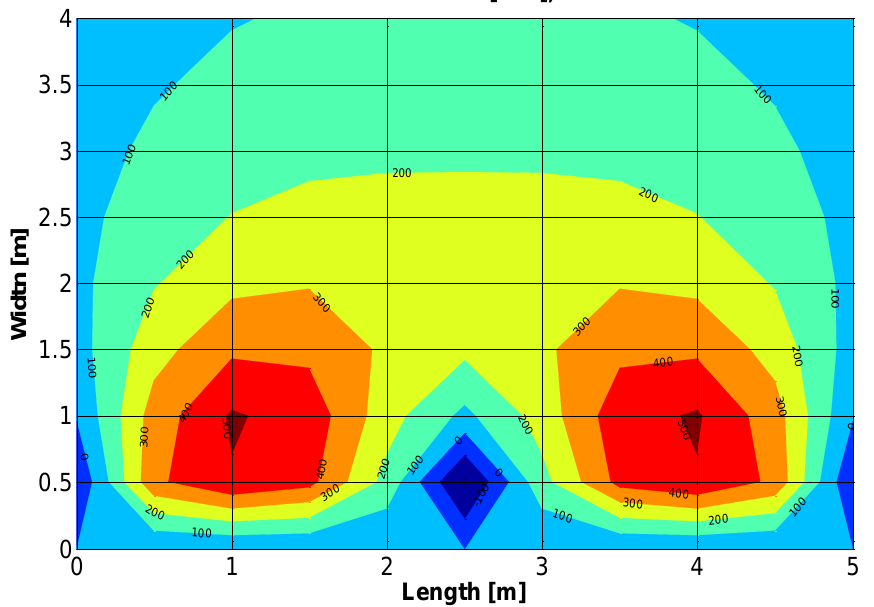
Figure 15. Modelization results with no control actions: room illuminance.